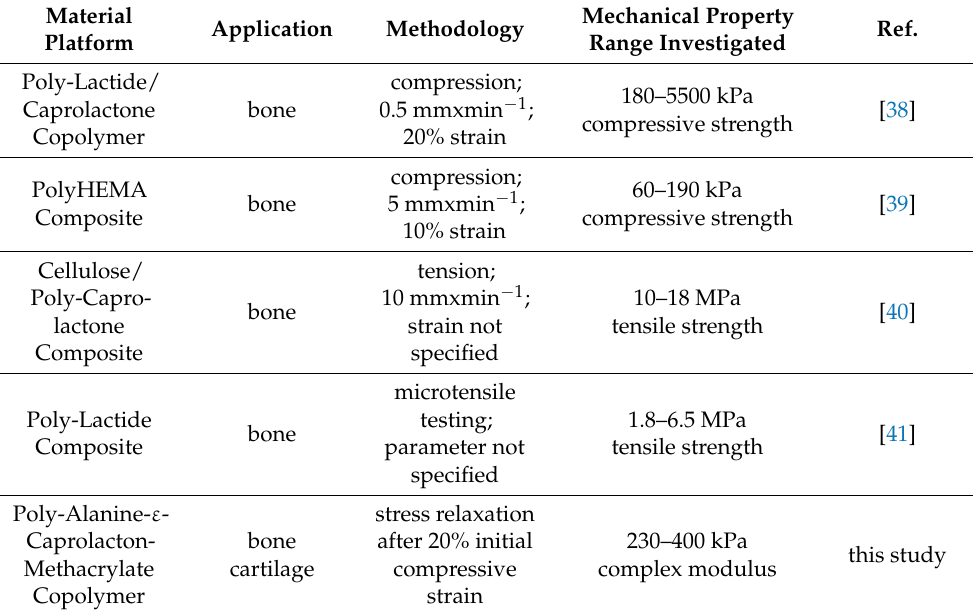
Table 2. Comparison of mechanical measurements on material platforms used for scaffolds in bone healing